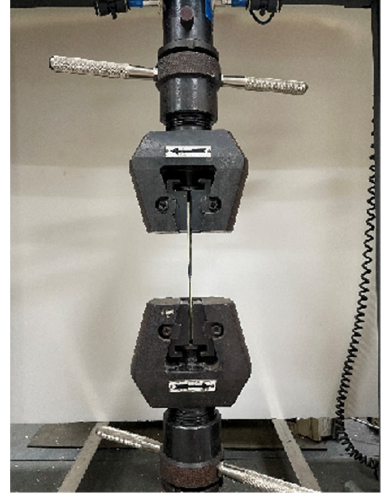
Figure 6. Picture of electronic universal testing machine.